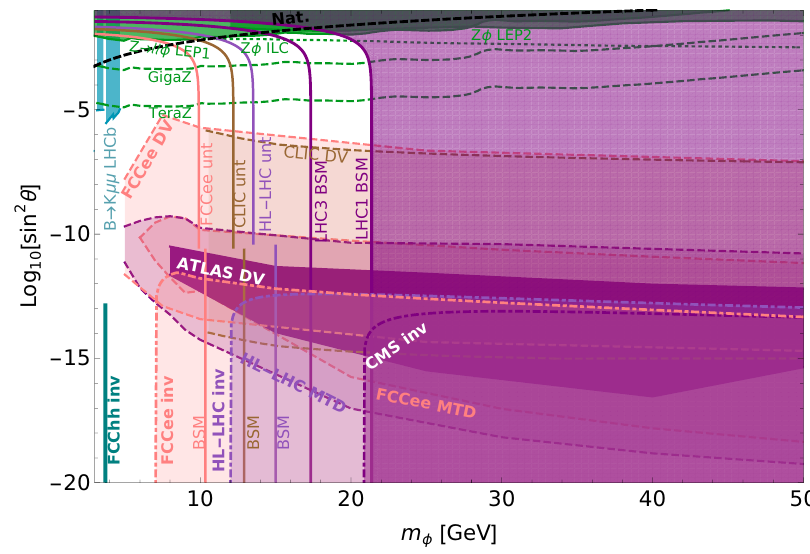
Figure 9 . Bounds on sin 2 θ and m φ for the scalar singlet, with λ hφ = m 2 various hadron and lepton colliders and covering a large range of life times. The bounds labeled by BSM arise from the collider indicated by the untagged bound of the same color. For the bounds in the prompt region see also refs. [19,